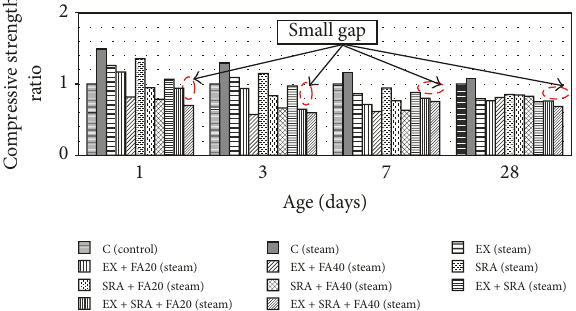
Figure 7: Compressive strength ratio of steam-cured